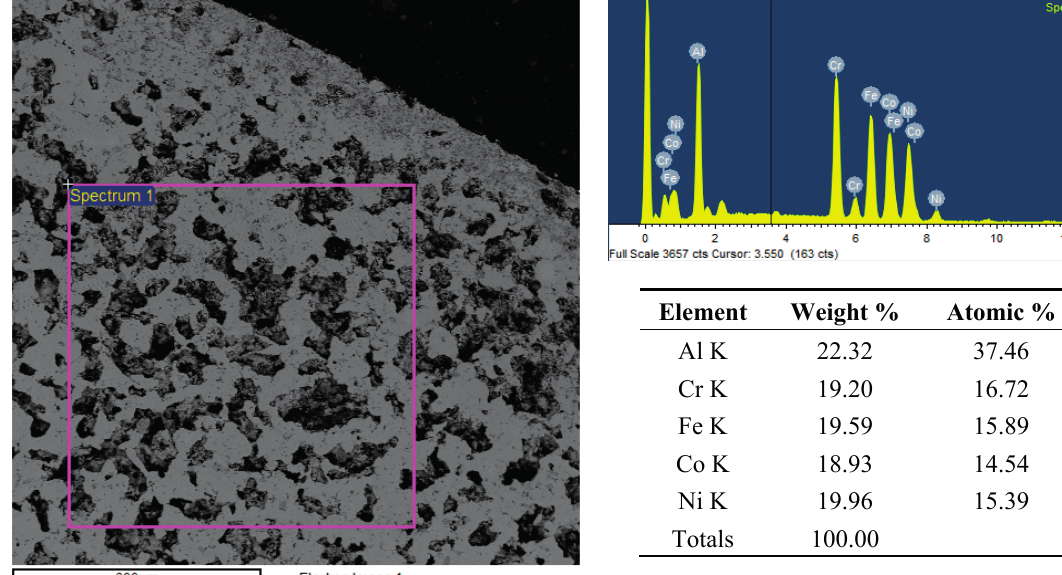
Figure 10. Backscattered electron SEM micrographs and EDS spectra and elemental analysis of the FeCoCrNiAl 2.5 sample’s surface after microwave heating at 700 W, 2450 MHz, in regions of the predominant electric field of the applicator (forming pressure = 300